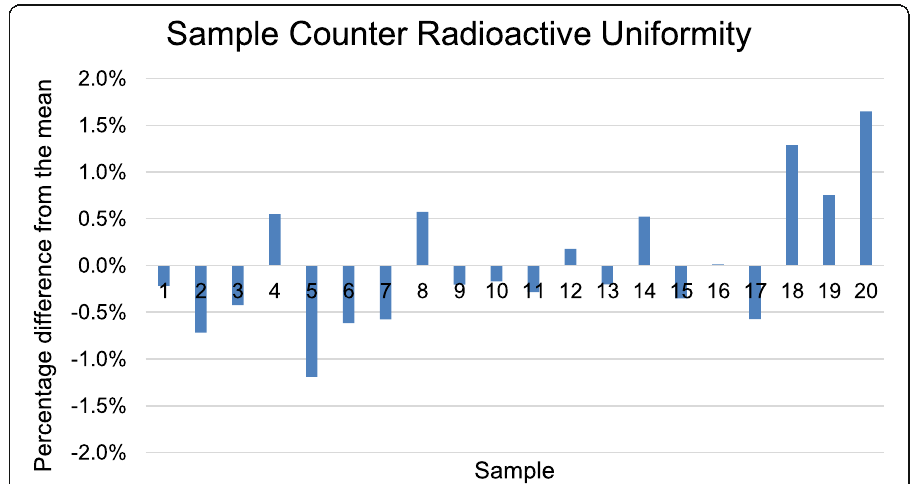
Fig. 4 Chart showing the percentage differences from the mean counts for the cylinders acquired by